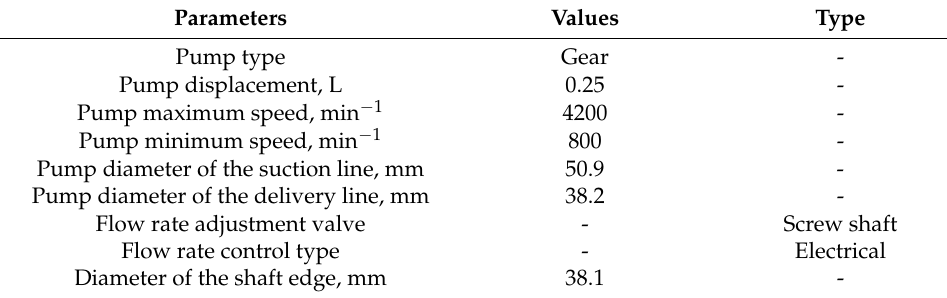
Table 2. Main characteristics of the hydraulic braking system.